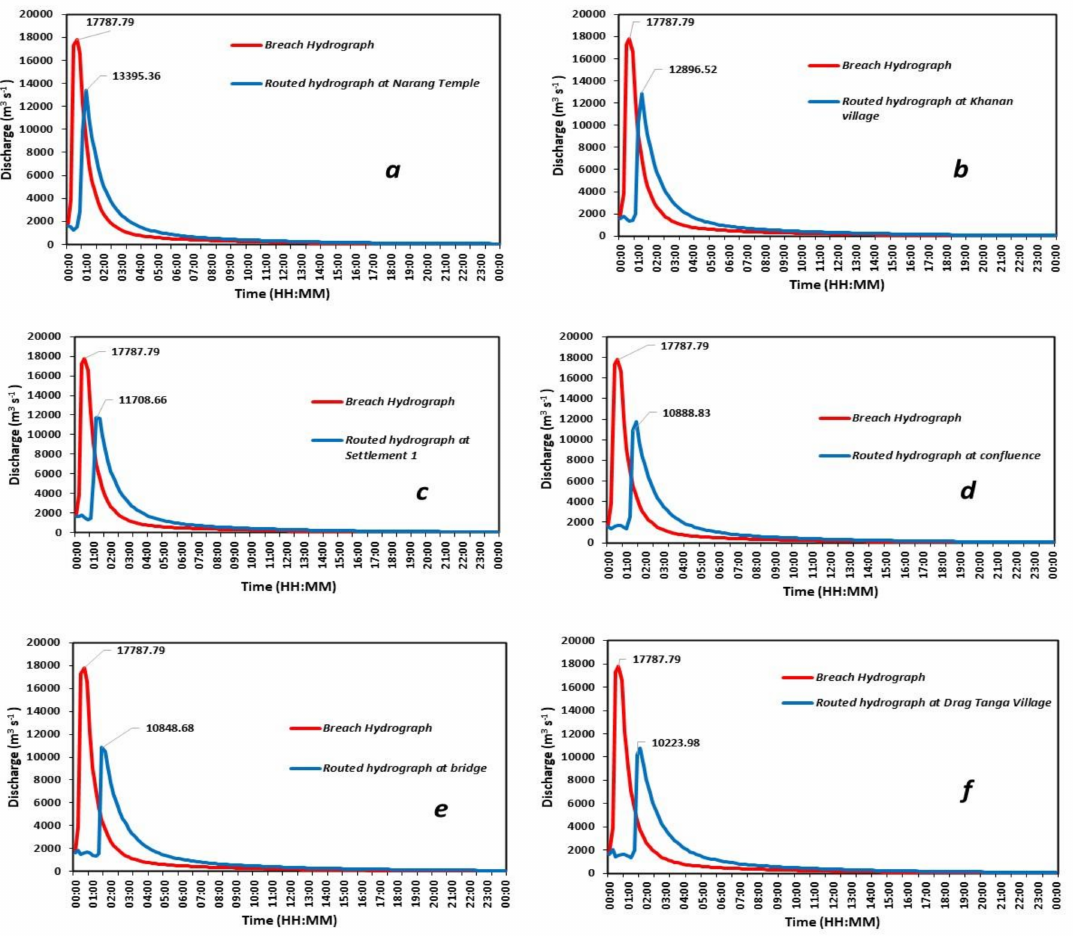
Figure 17. Routed hydrographs at six important locations along the flow channel: ( a ) Naranag temple;